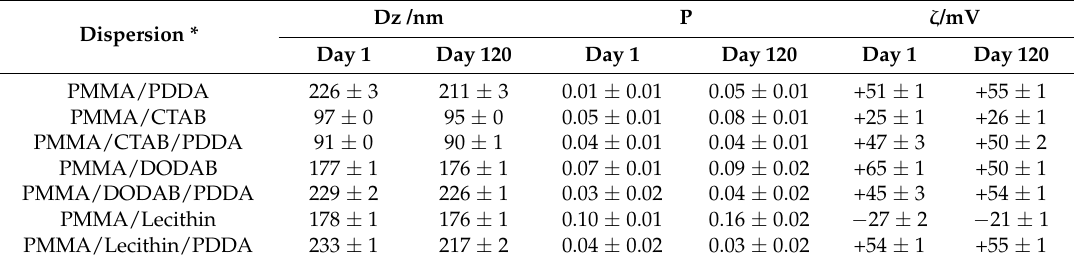
Table 5. The colloidal stability of NPs dispersions from sizing (Dz), polydispersity (P), and zeta-potential ( ζ ) for dispersions aged 1 and 120 days after